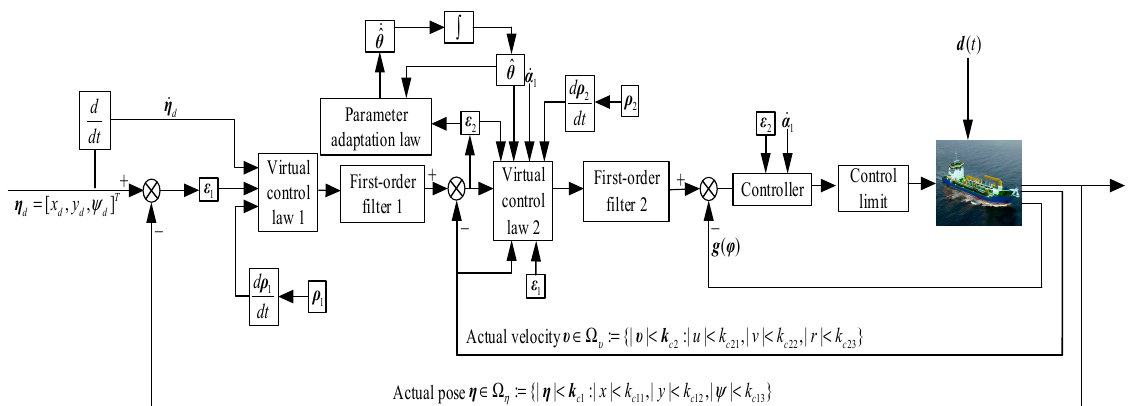
Figure 2. The block diagram of adaptive dynamic surface constraint control for marine surface vessel.